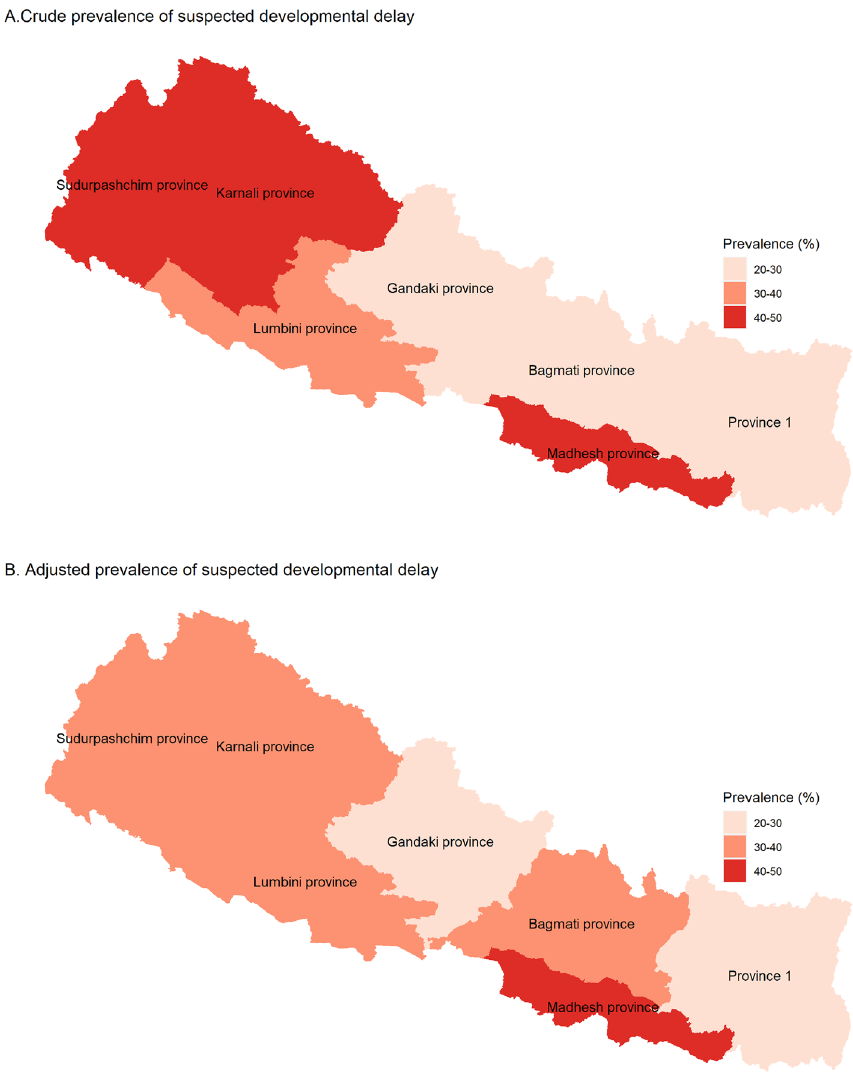
Figure 2. Crude and adjusted prevalence of suspected developmental delays among Nepalese children aged 3–4 years. Models were adjusted for child’s age, sex, nutritional status (stunting), mother’s education, and household socioeconomic status. Exact values along with 95% confidence intervals are presented in Table